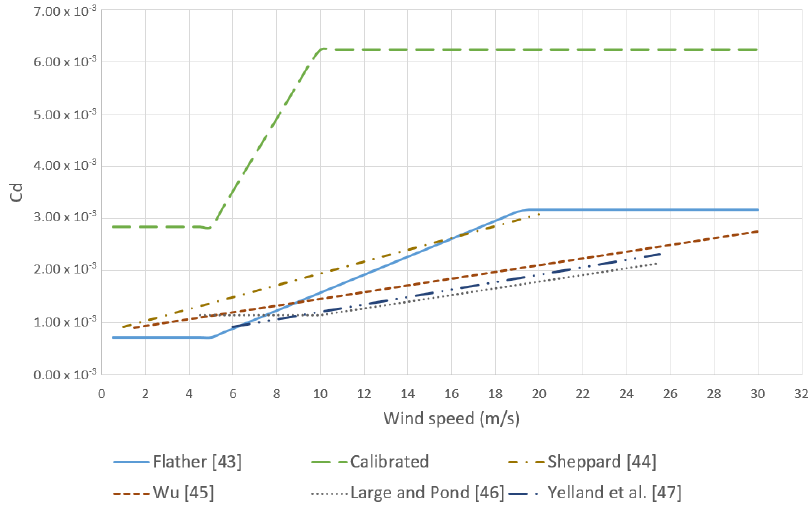
Figure 9. Final C d values used for the storm surge model compared with the other common wind drag